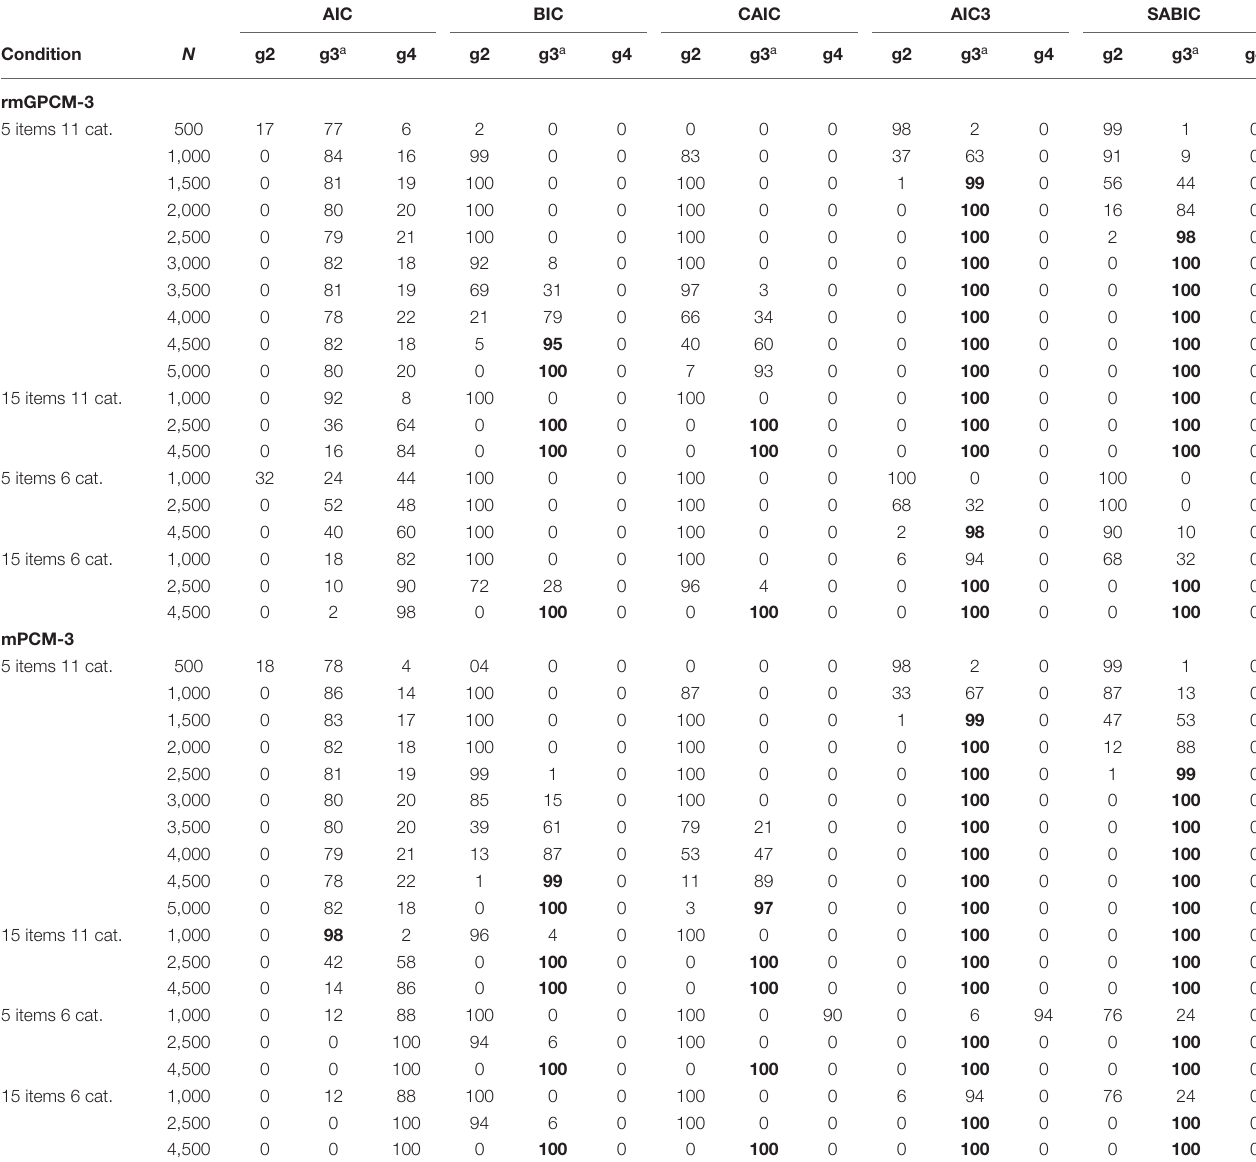
TABLE 7 | Model selection for the rmGPCM and the mPCM under the condition of a true three-class